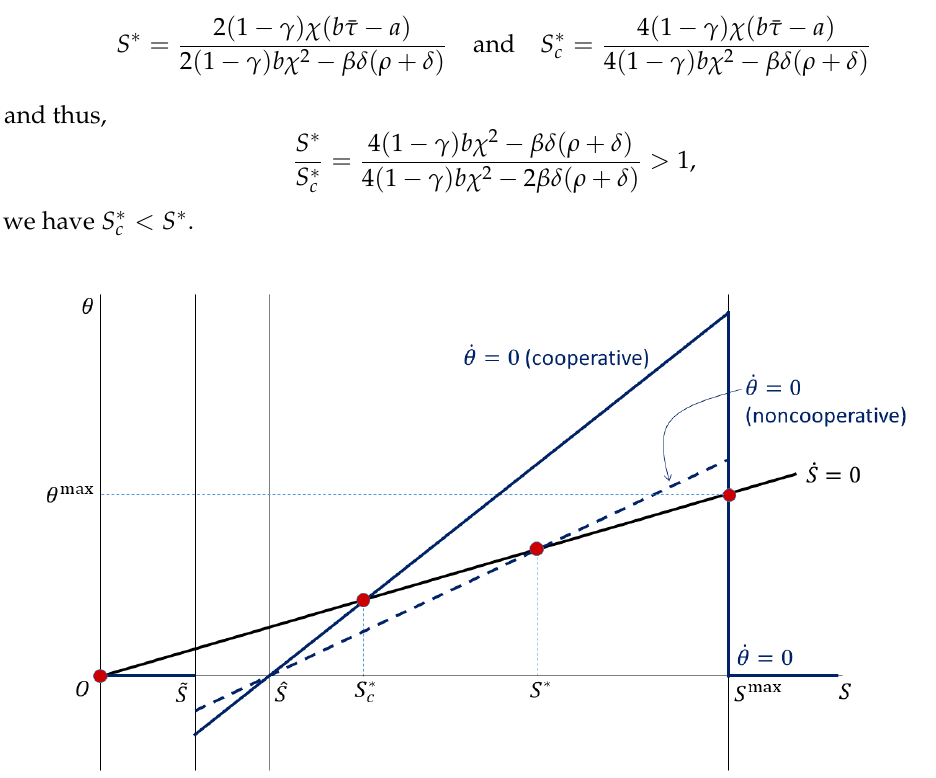
Figure 7. Comparison of steady states between noncooperative and cooperative